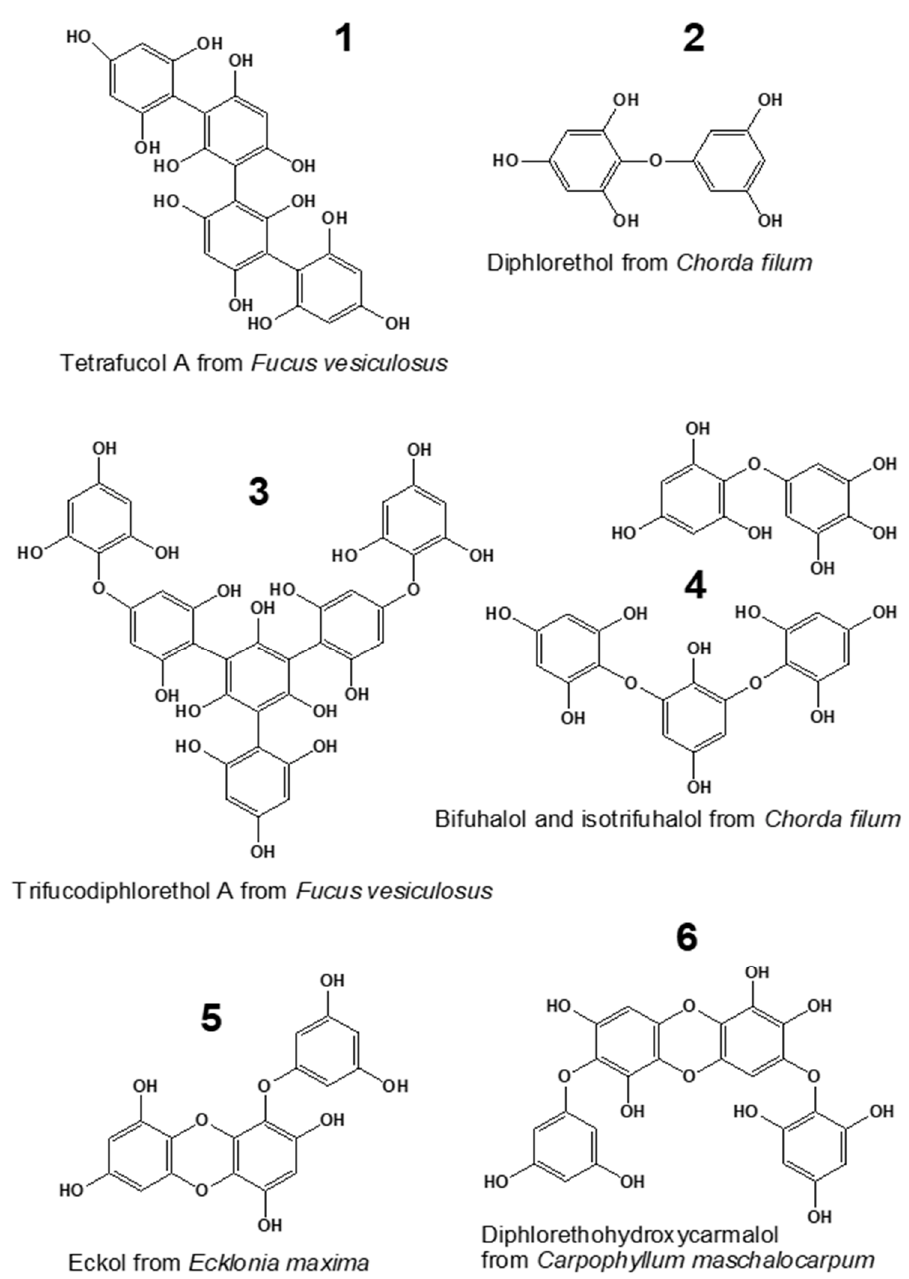
Figure 1. Compounds representing six major phlorotannin classes: fucols ( 1 ), phlorethols ( 2 ), fucophlorethols ( 3 ), fuhalols ( 4 ), eckols ( 5 ), and carmalols ( 6 ) [3,7,8].